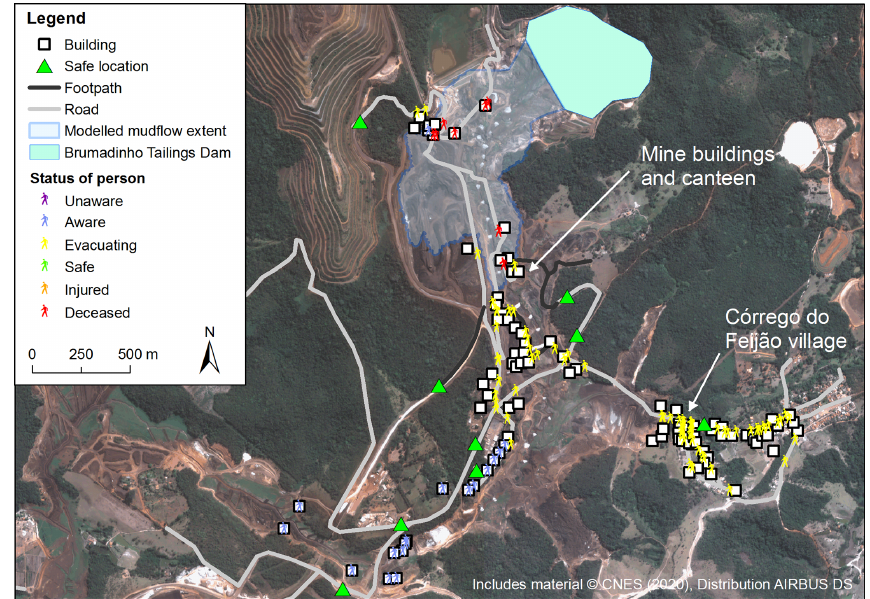
Figure 10. An example of an output from the LSM emergency planning modelling 90s after the Brumadinho tailings dam failure assuming a warning is issued at the time of the